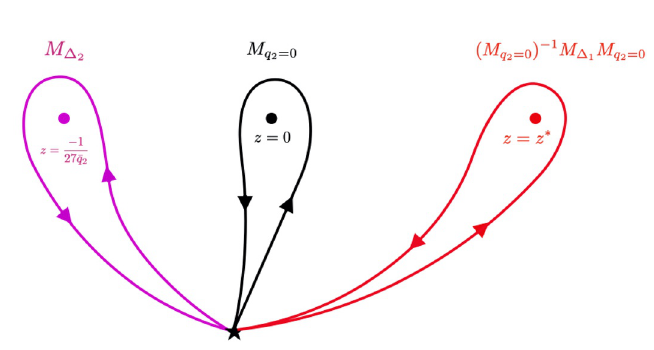
Figure 5. Positions of the regulator strings at z = − 1 and z = z ∗ relative to the EFT string 27¯ q 2 with charge e = (0 , 1) at z = 0 . Here we chose | ¯ q 2 | > 0 and 1 / 432 > | ¯ q 1 | . We also indicated the monodromies when encircling the three strings counter-clockwise with a common base